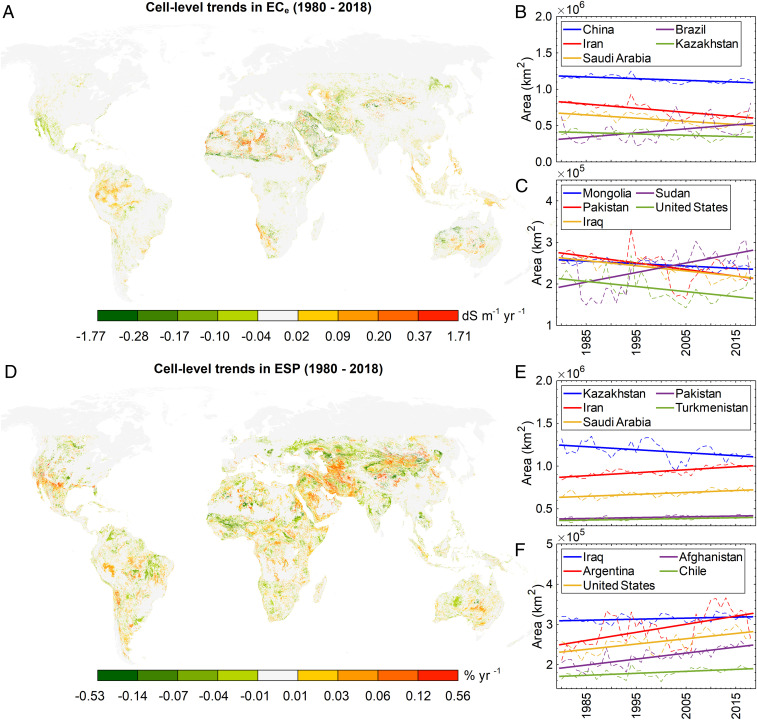
Variations in the soil cell-level salinity/sodicity and country-level area of the salt-affected soils (P < 0.05). (A and D) Cell-level variations in ECe and ESP between 1980 and 2018, respectively. Soil cell is any ∼1- × 1-km stretch of the soil. Maps are delimited to −55 and 55 latitudes and higher latitudes are shown only for improving the visualization of the maps. (B and C) Variations in the total area of soils with salinity of ECe ≥4 dS⋅m−1 since 1980, at the country level. (E and F) Variations in the total area of soils with sodicity of ESP ≥6% since 1980, at the country level (see SI Appendix, Tables S22 and S23 for annual gain or loss in the total area of salt-affected soils for all countries/states). Countries are sorted based on the mean annual area of soils with an ECe ≥4 dS⋅m−1 or ESP ≥6% between 1980 and 2018, largest to smallest.